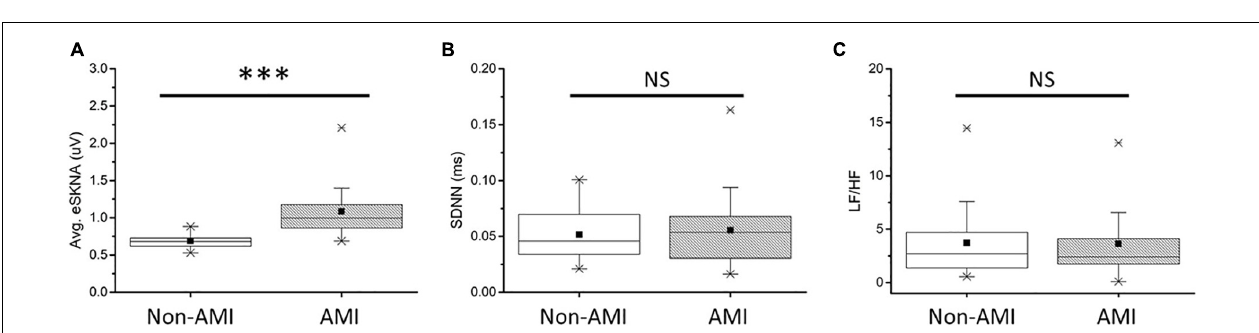
FIGURE 5 | (A) Average eSKNA is statistically significant between non-AMI and AMI groups. (B) SDNN does not exist statistically significant between non-AMI and AMI groups. (C) LF/HF ratio does not exist statistically significant between non-AMI and AMI groups. ∗∗∗ Statistically significant ( p < 0.001); NS, not